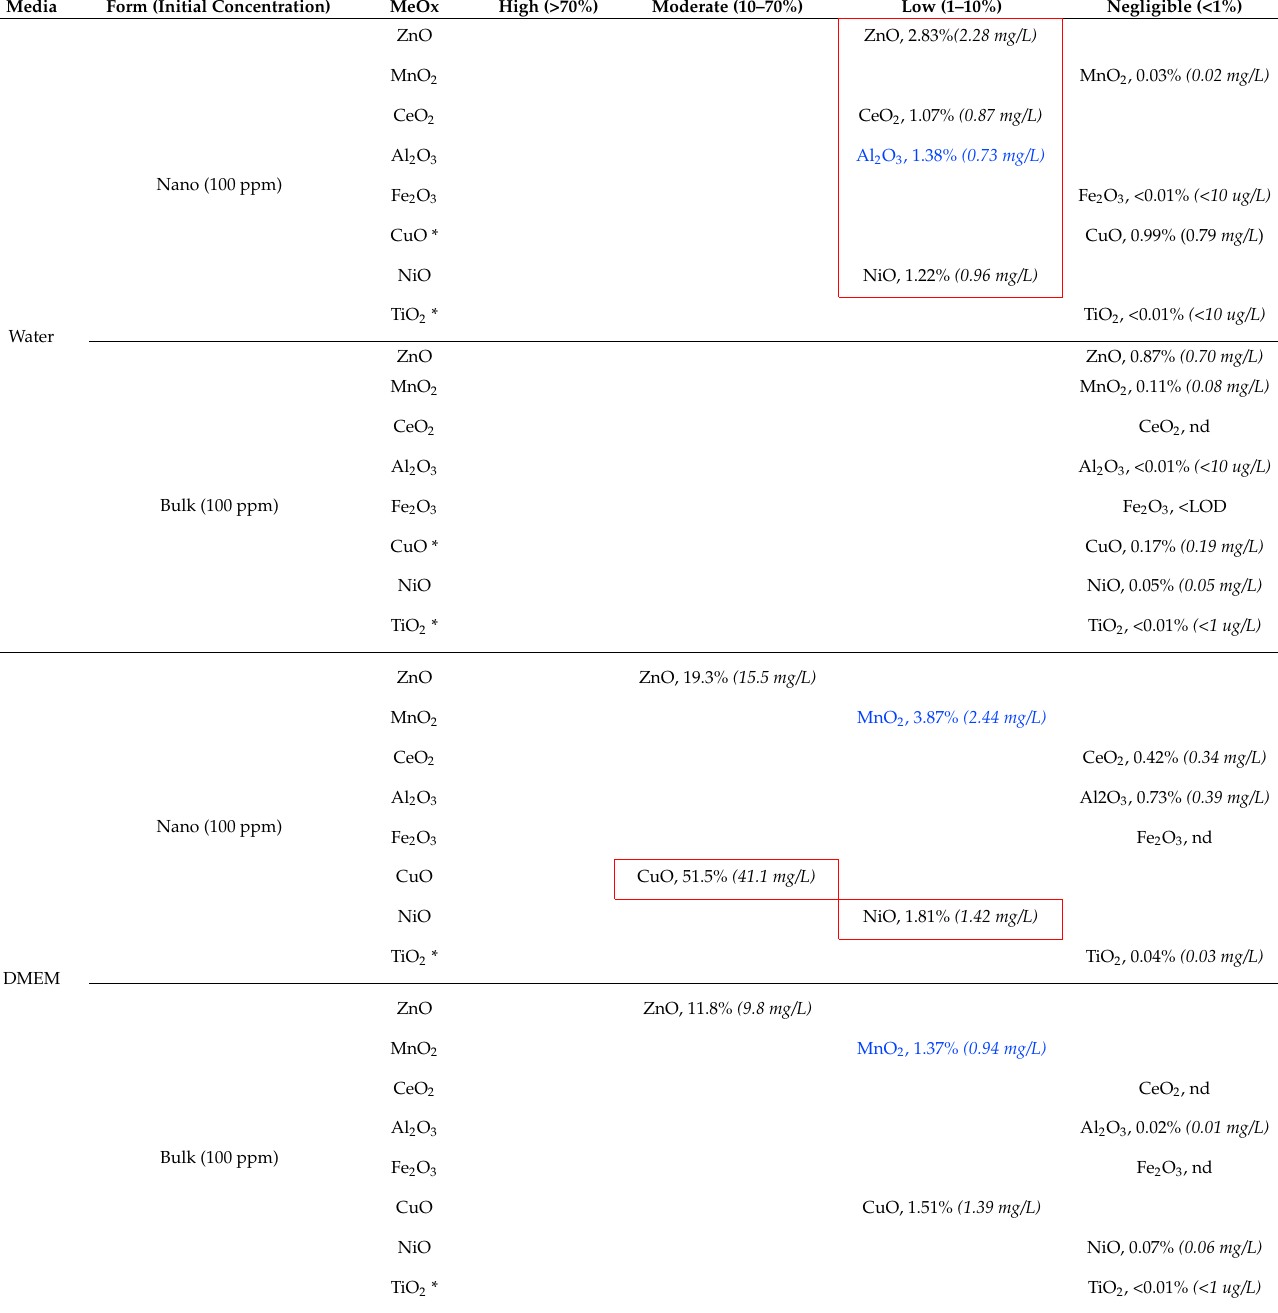
Table 2. Grouping of MeOx ENMs and their bulk analogues based on dissolution results in wa- ter and DMEM (48 h of incubation, 100 mg/L initial concentration) using screening criteria from OECD ENV/JM/MONO (2015)44. Results from the current study (MnO 2 , ZnO, CeO 2 , Al 2 O 3 , Fe 2 O 3 ) combined with results from Avramescu et al. [2020] (CuO, NiO, TiO 2 ). In blue are the ones that fall in a different category (“negligible”) at 24 h than at 48 h. Red boxes show nano falling in a different category than bulk (nd = not detected; <LOD = below the limit of detection); * 24 h results (48 h not